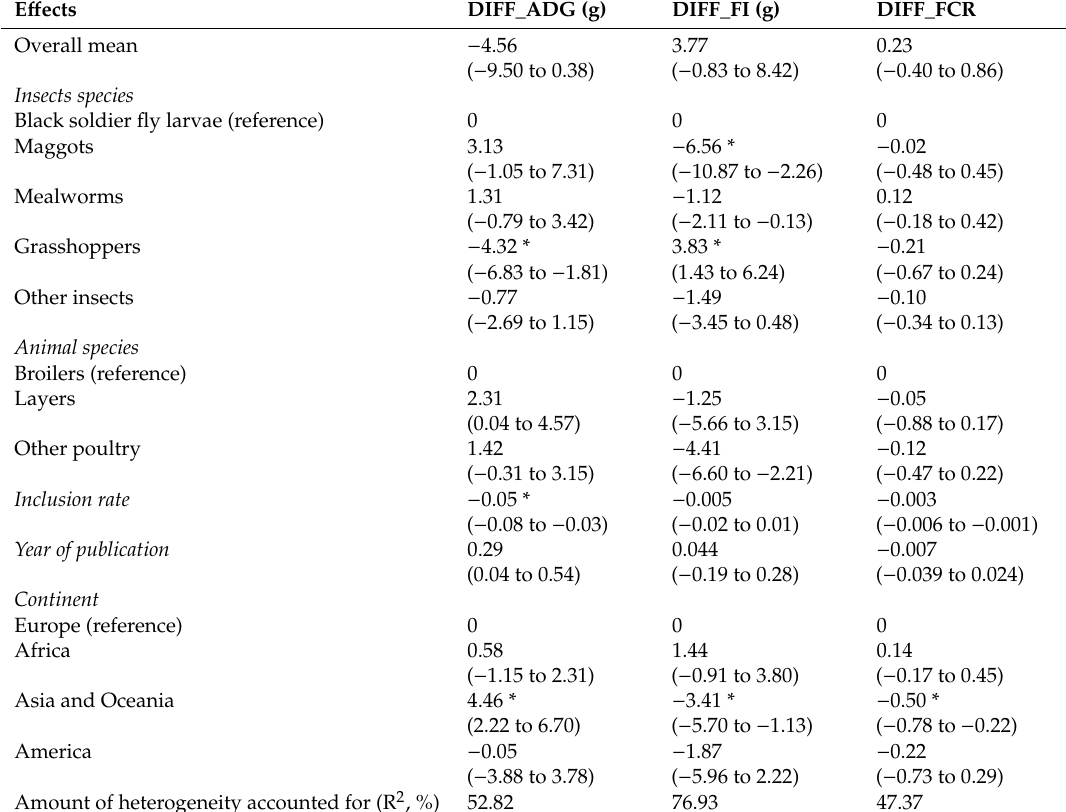
Table 2. Estimates of the e ff ects of the characteristics of the study (continent and year of publication) and of the trial (categories of birds, of insects, and percent of insects’ inclusion) on the di ff erences in means of the average daily gain (DIFF_ADG), feed intake (DIFF_FI), and feed conversion ratio (DIFF_FCR) between poultry fed a diet with vs. without